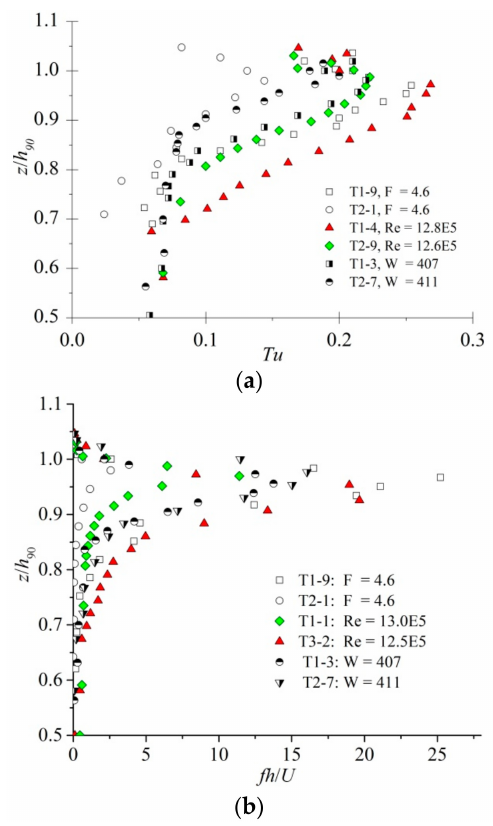
Figure 9. Distributions of turbulence intensity ( a ) and bubble frequency ( b ) with identical F, Re, W.